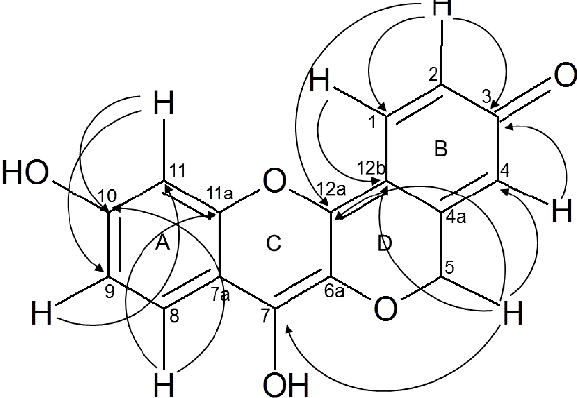
Figure 1. Peltomexicanin, multiple long range correlations observed by HMBC.